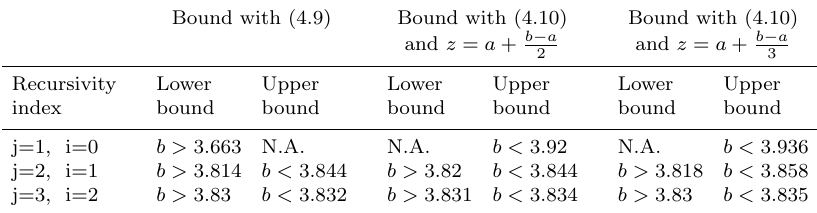
Table 2. Comparison of bounds for b in the Example 2. Bound with (4.9) Bound with (4.10) Bound with (4.10) and z = a + b − a and z = a + b − a 2 3 Recursivity Lower Upper Lower Upper Lower Upper index bound bound bound bound bound bound j=1, i=0 b > 3 . 663 N.A. N.A. b < 3 . 92 N.A. b < 3 . 936 j=2, i=1 b > 3 . 814 b < 3 . 844 b > 3 . 82 b < 3 . 844 b > 3 . 818 b < 3 . 858 j=3, i=2 b > 3 . 83 b < 3 . 832 b > 3 . 831 b < 3 . 834 b > 3 .